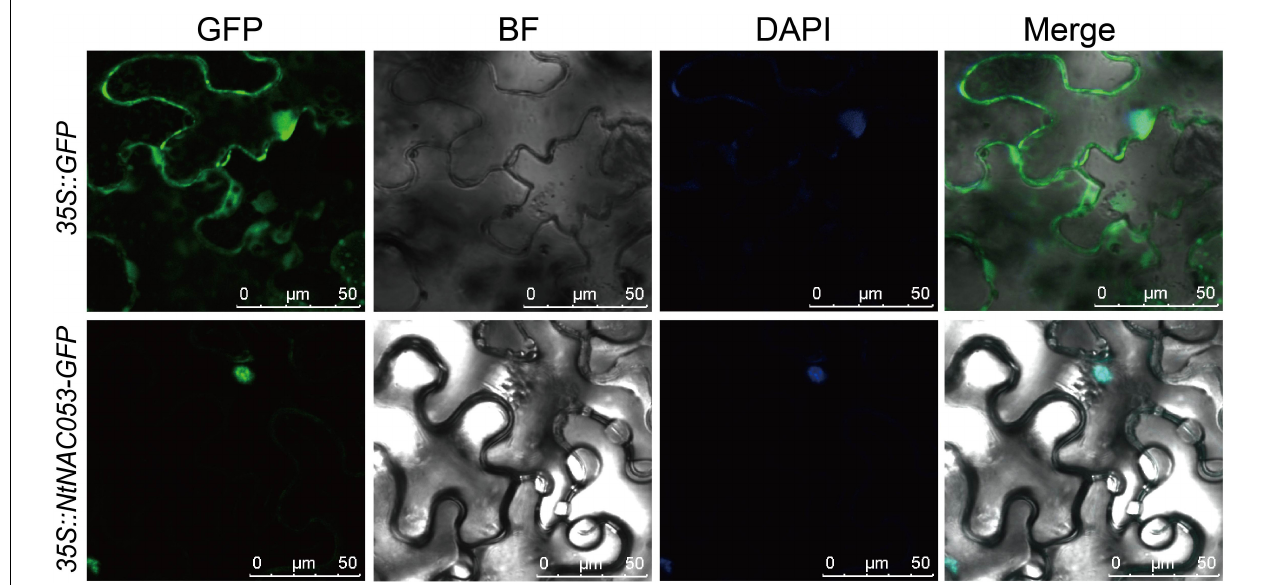
FIGURE 2 | The subcellular localization of the NtNAC053 protein in Nicotiana benthamiana epidermal cells. Transient expression of GFP and NtNAC053-GFP in N. benthamiana epidermal cells. Bar = 50 µ M, DAPI, 4,6-diamidino-2-phenylindole for nuclear staining.